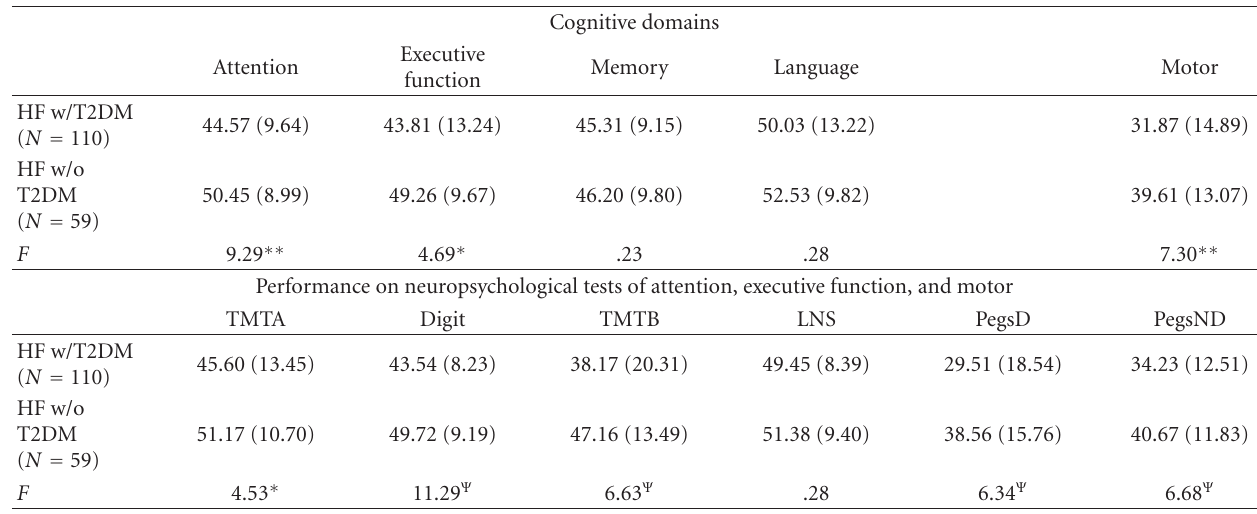
Table 3: T -score means and standard deviations of cognitive test performance for heart failure patients with and without type-2 diabetes mellitus.